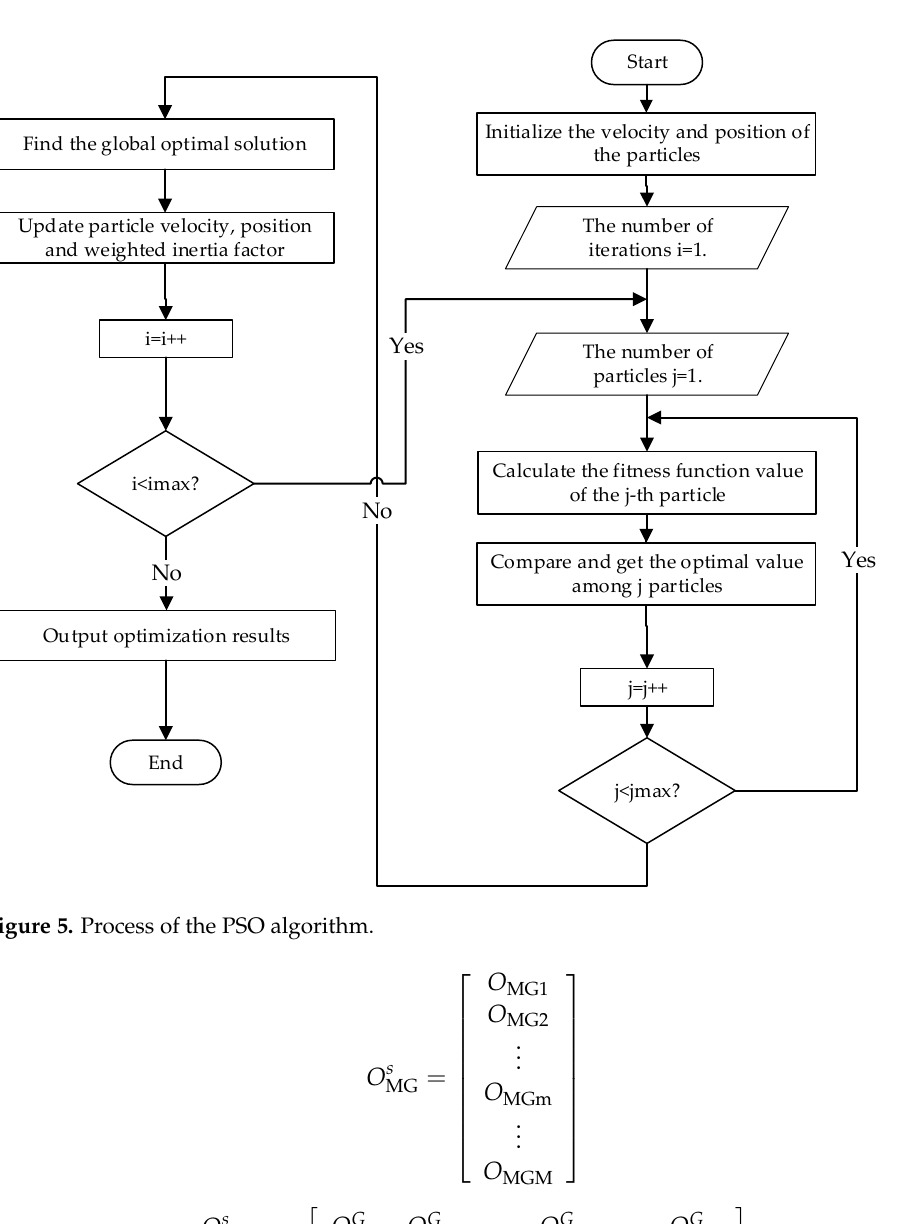
Figure 5. Process of the PSO algorithm.